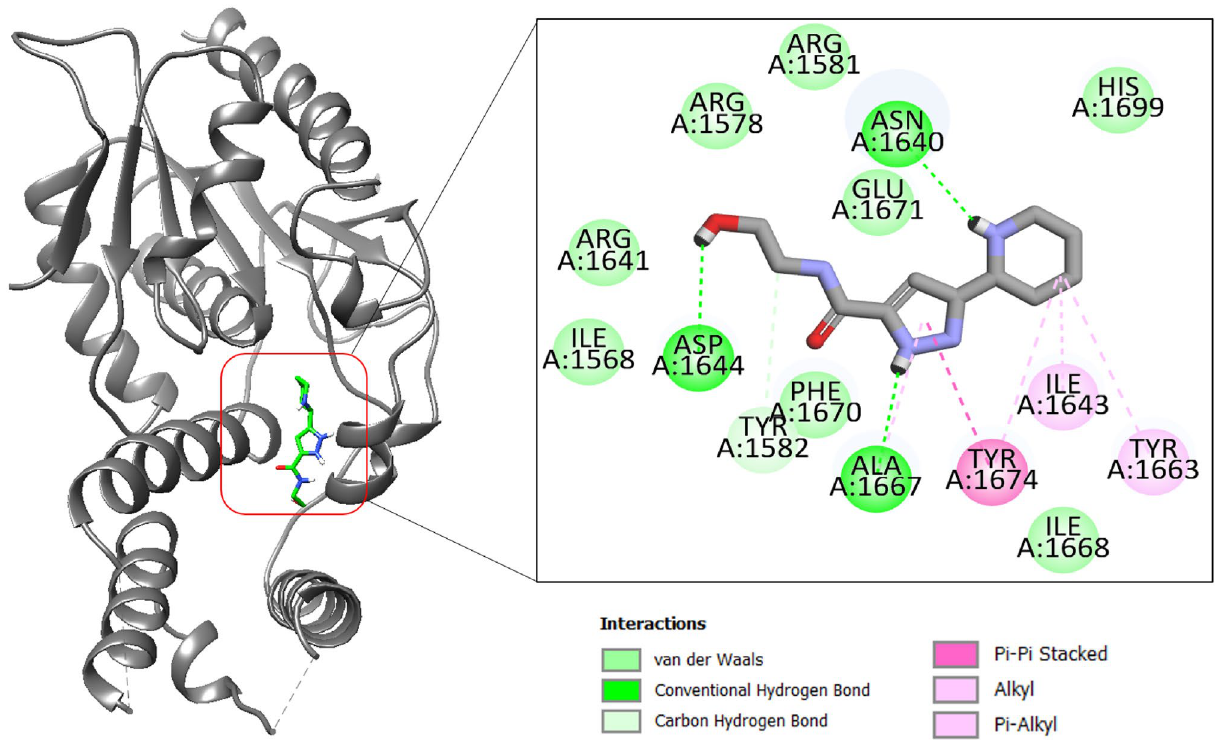
Figure 2. Binding mode of compound BBD_30878599 at the active pocket of polyketide synthase Pks13. The receptor enzyme is given in gray cartoon while the compound is presented in green stick. The binding interactions network is also